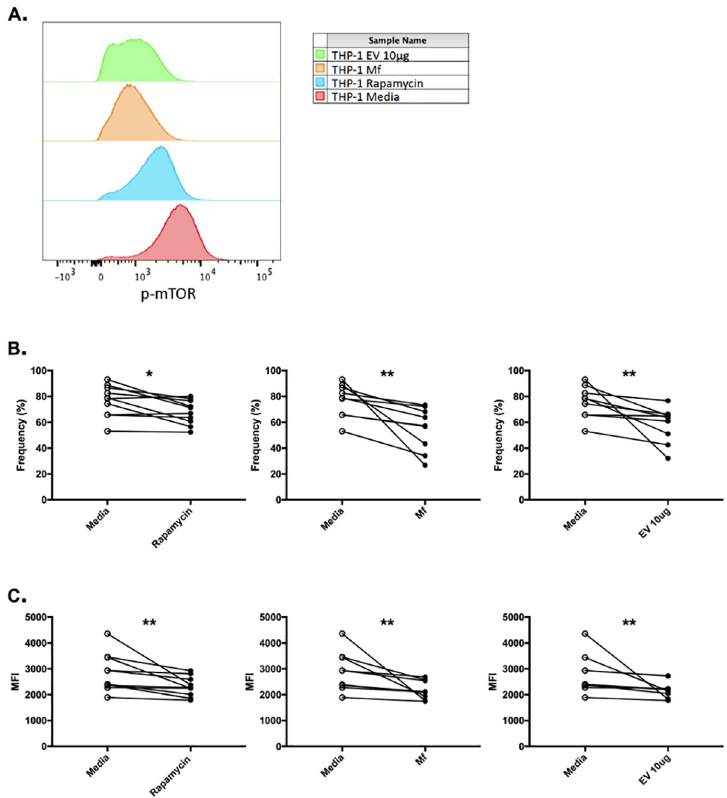
Fig 6. Mf-derived EVs downregulate mTOR phosphorylation in human monocytes. Human THP-1 cells were cultured in the presence of media alone, rapamycin, live mf, or mf-derived EVs for 1 hour at 37˚C in 5% CO 2 . Following the stimulation, fixation, permeabilization, and intracellular staining for phosphorylated mTOR was performed on the cells. The samples were analyzed by flow cytometry; a representative plot demonstrates the assessment of phosphorylated mTOR (Phospho-mTOR (Ser2448)) (A). The results are presented as both frequencies (B) and MFI values (C). n = 10 for rapamycin condition, n = 9 for both live mf and EV conditions. � : � 0.05, �� : �